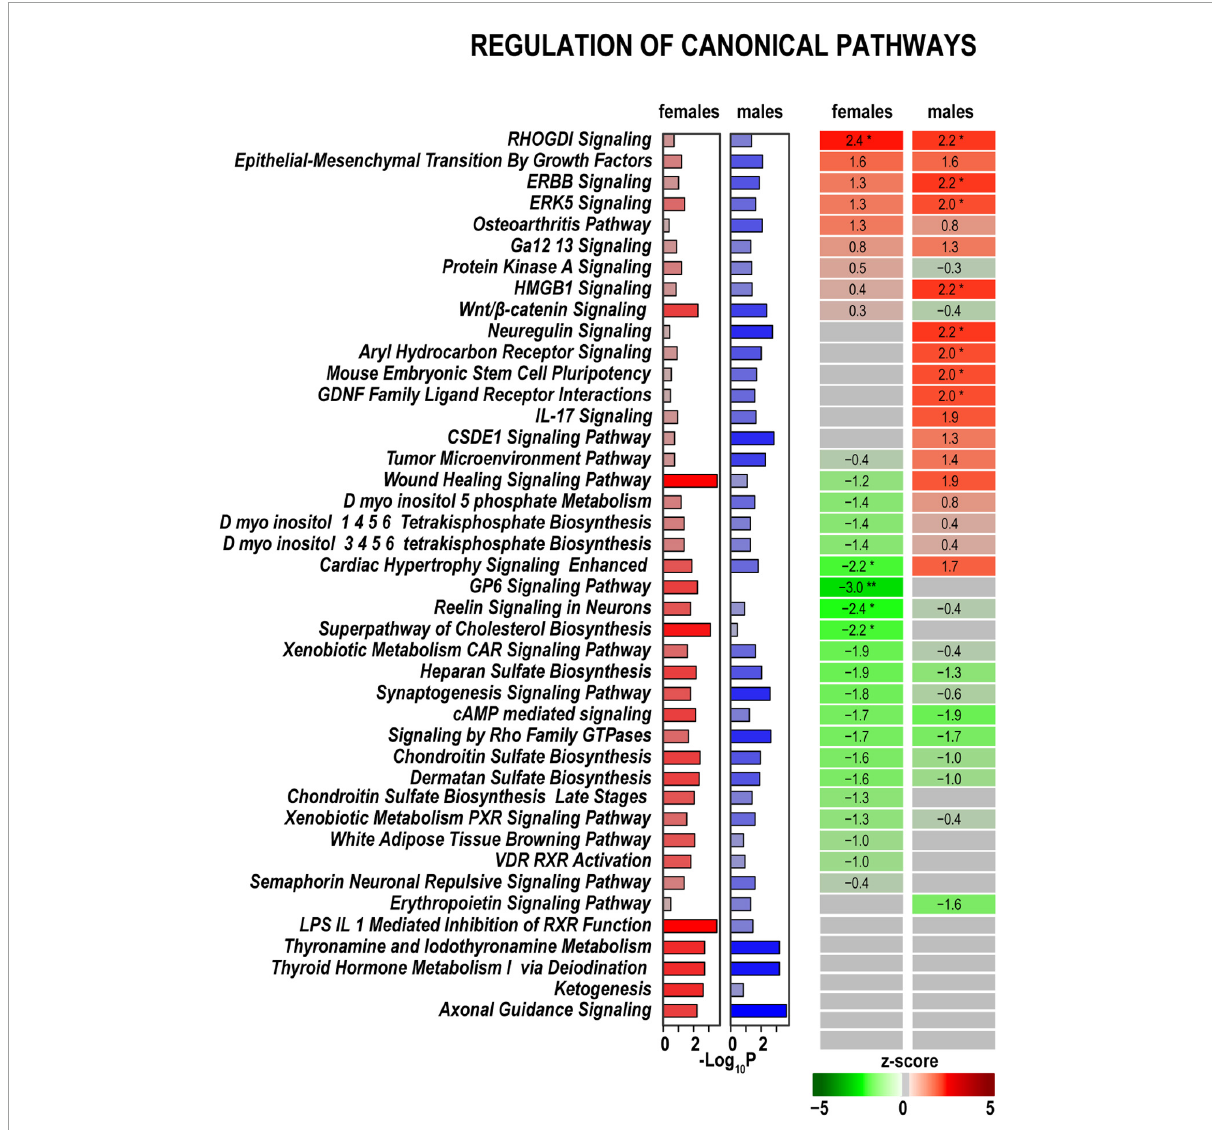
FIGURE3 Canonical signaling pathways demonstrate distinct regulation patterns in females and males. Canonical pathways were predicted in IPA and ranked by z-scores. Positive (red) and negative (green) z-scores indicate pathway up-regulation or down-regulation, respectively, according to the color scale. Asterisks indicate significance *, z < –2.0 or z > 2.0; **, z < –3.0, or z > 3.0. The gray color indicates that the directionality of pathway regulation was not determined. Purple (females) and blue (males) horizontal bars correspond to –log 10 (P) ≥ 1.3 calculated in IPA using Fisher exact